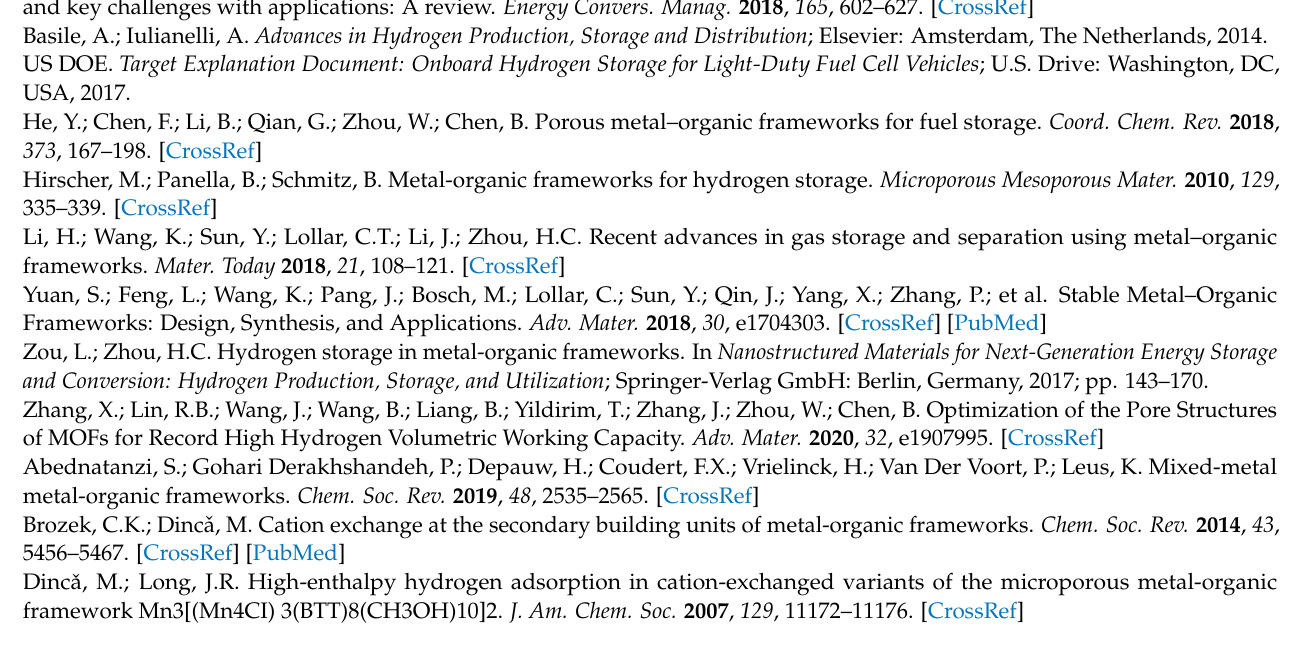
Figure S4: SEM image and EDS mapping, Figure S5: The EDX analysis of the Co-MOF-5 sample, Figure S6: FT-IR spectrum of MOF-5 (as-synthesized), Figure S7: FT-IR spectrum of Ni-MOF-5, Figure S8: FT-IR spectrum of Co-MOF-5, Table S1: Hydrogen adsorption in mixed-metal